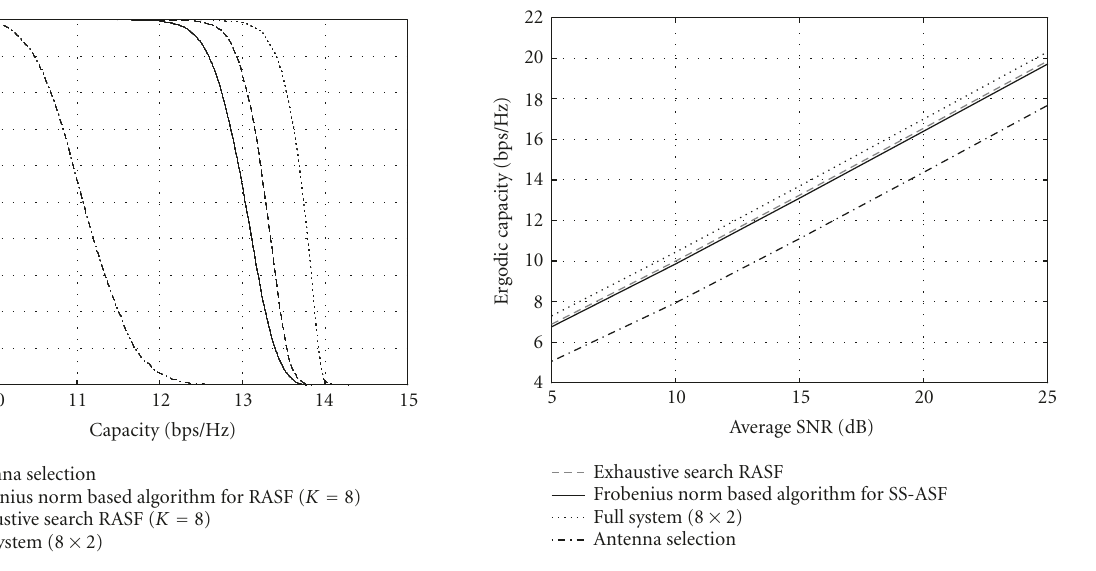
Figure 4: Empirical complementary cdf of the capacity of the resulted system when the Frobenius-norm-based algorithm for strictly structured receive antenna subarray formation (SS-ASF) is applied to a 8 × 2 Rayleigh i.i.d. channel with SNR = 15dB. The per- formance of the algorithm is compared with the exhaustive search solution for SS-ASF, the full system (8 × 2), and Gorokhov et al. decremental algorithm for antenna selection.